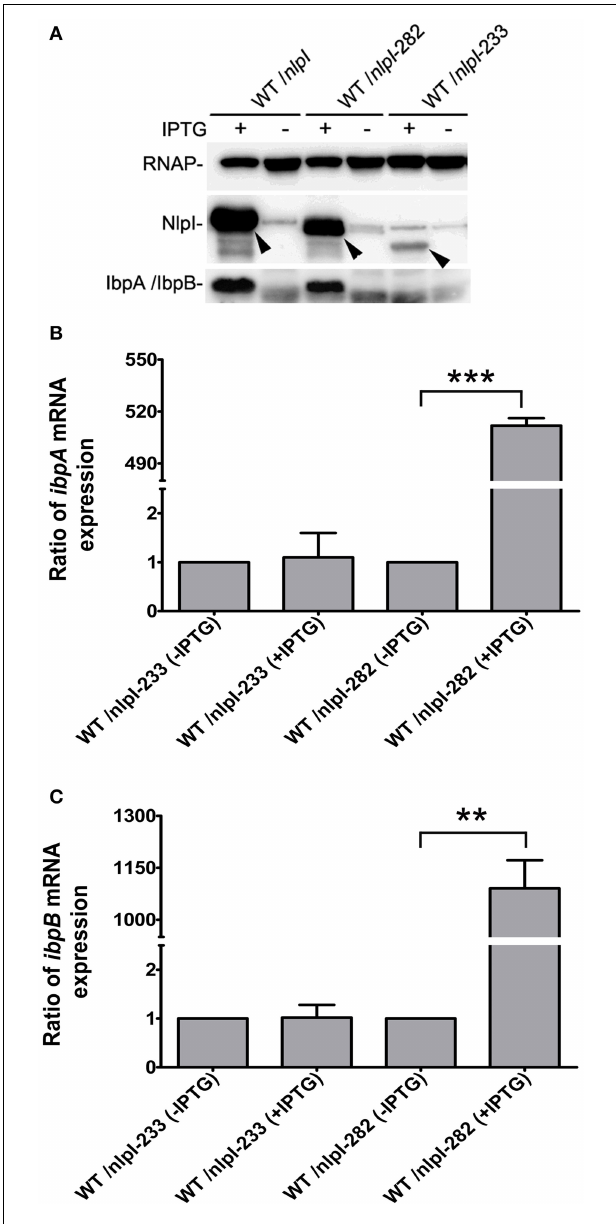
FIGURE 4 | C-terminal of NlpI involved in the transcription of ibpA and ibpB . (A) Western blot with anti-NlpI and anti-IbpA antibody detected that IbpA and IbpB were increased in CP after the induction of nlpI or nlpI -282, but not in the over-expression of nlpI -233 cells. (B, C) qRT-PCR showed that the mRNA levels of ibpA and ibpB after the induction of nlpI -282 were increased by 511.8 ± 4.4, 1090.7 ± 81.4 fold, respectively, compared with corresponding stain without IPTG. But the mRNA levels of ibpA and ibpB after the induction of nlpI -233 were 1.1 ± 0.5, 1.02 ± 0.26 fold, respectively, compared with corresponding stain without IPTG. ∗∗∗ P < 0 . 001, ∗∗ P < 0 . 01.